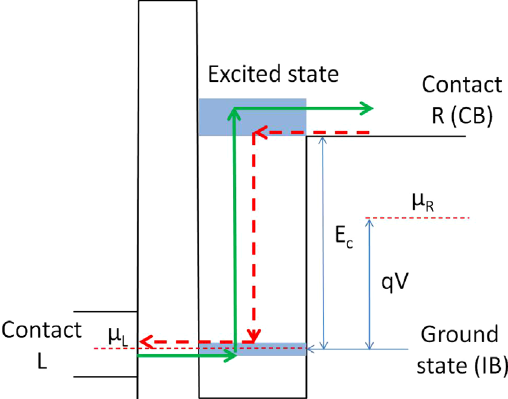
Fig. 1. Schematic representation of the modeled system. The full-arrows show the radiative excitation and the collection while the dash-arrows represent the injection and the emission. We also show the two Fermi levels m R and m L , respectively, corresponding to the IB and the n-type contact. The grey surfaces represent the